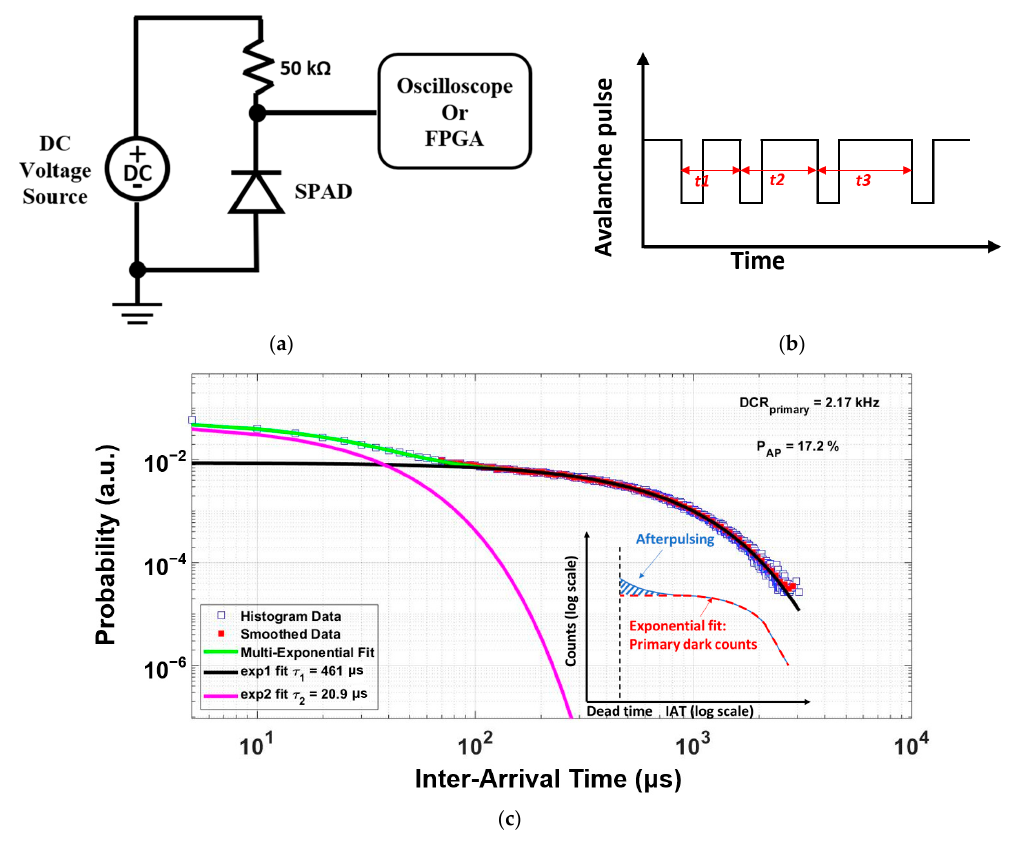
Figure 7. Characterization of SPADs’ timing ji tt er ( a ) Measurement setup ( b ) Output waveforms ( c ) An example of measured afterpulsing probability with the illustration (bo tt om right) [29].